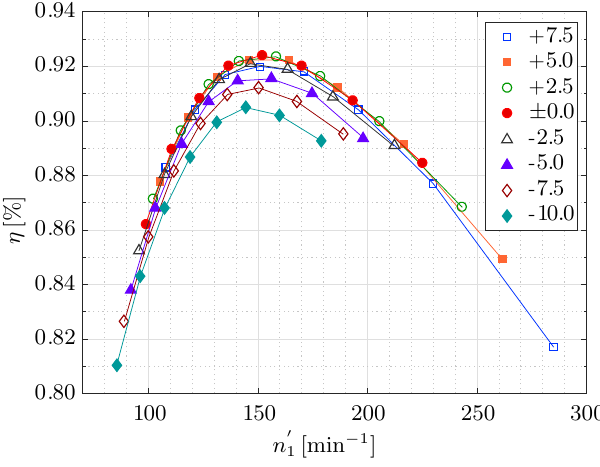
Fig. 9. Distribution of meridional velocity c m upstream and downstream of the runner in turbine mode